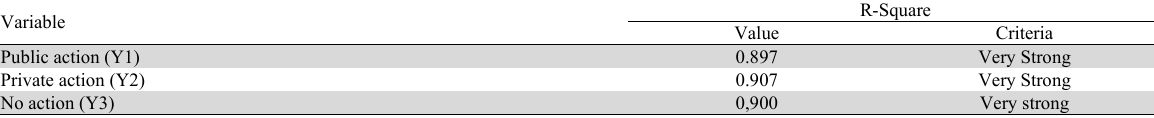
The R-square (R2) Value of the Endogenous Variable